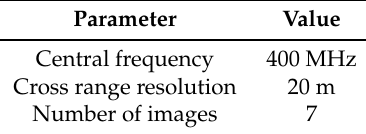
Table 1. Parameters of a typical P-band tomographic